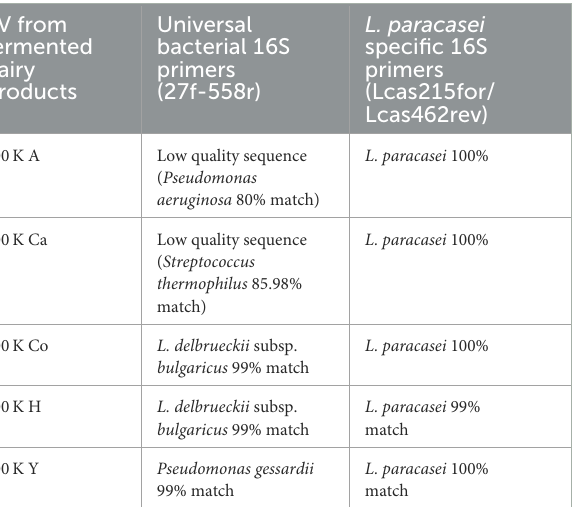
TABLE 2 Sequences obtained after the amplification of 16S rDNA from EV in the 100K pellets of the different fermented dairy products.